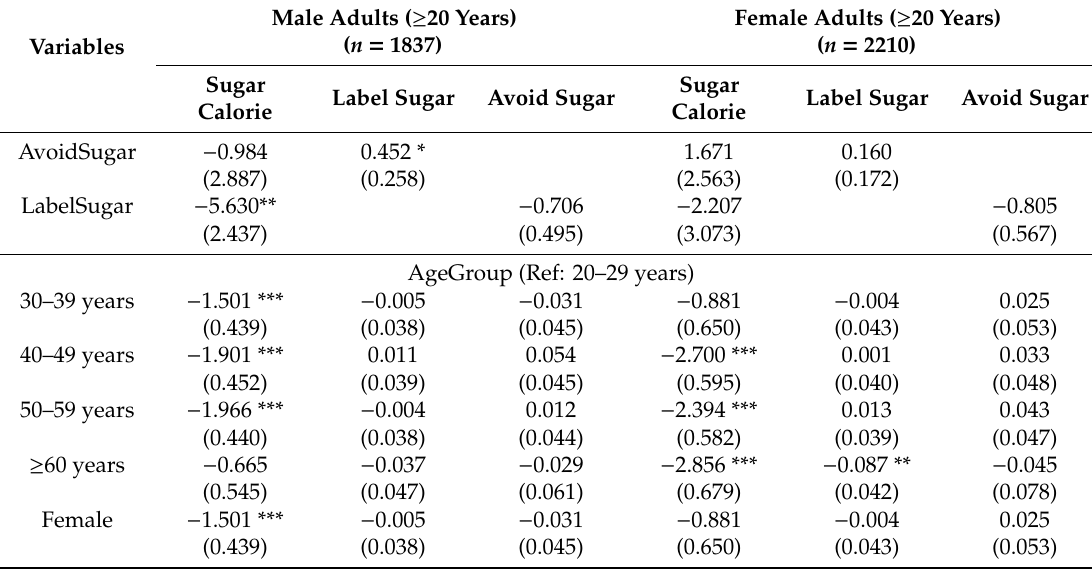
Table 4. 3SLS estimates for